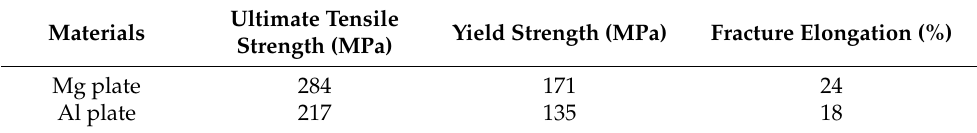
Table 2. Mechanical properties of AZ31B Mg plate and 5052 Al plate at room